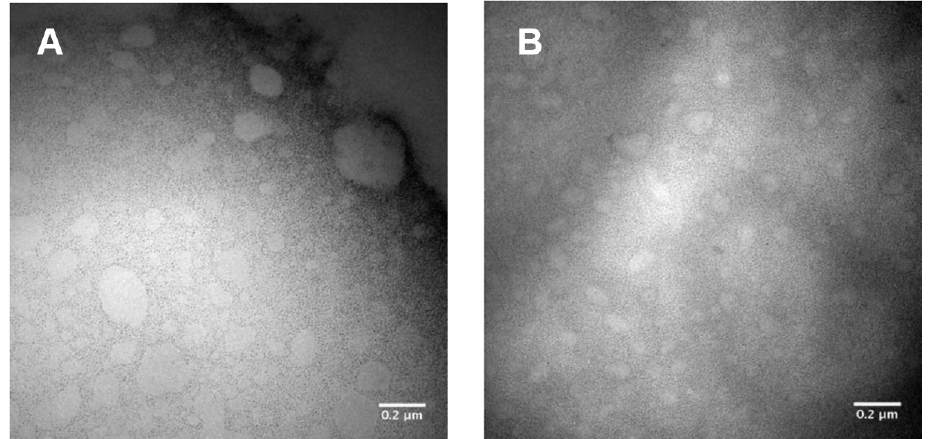
Figure 1. Representative images obtained by transmission electron microscopy of samples diluted 100 times in distilled water. Nano-1 ( A ) and Nano-2 ( B ). One hundred thousand times increase. The images show droplets with a well-defined outline, with an average diameter of 700 nm, more significant than that observed when the samples were analyzed by DLS, suggesting coalescence of the droplets during slide preparation.